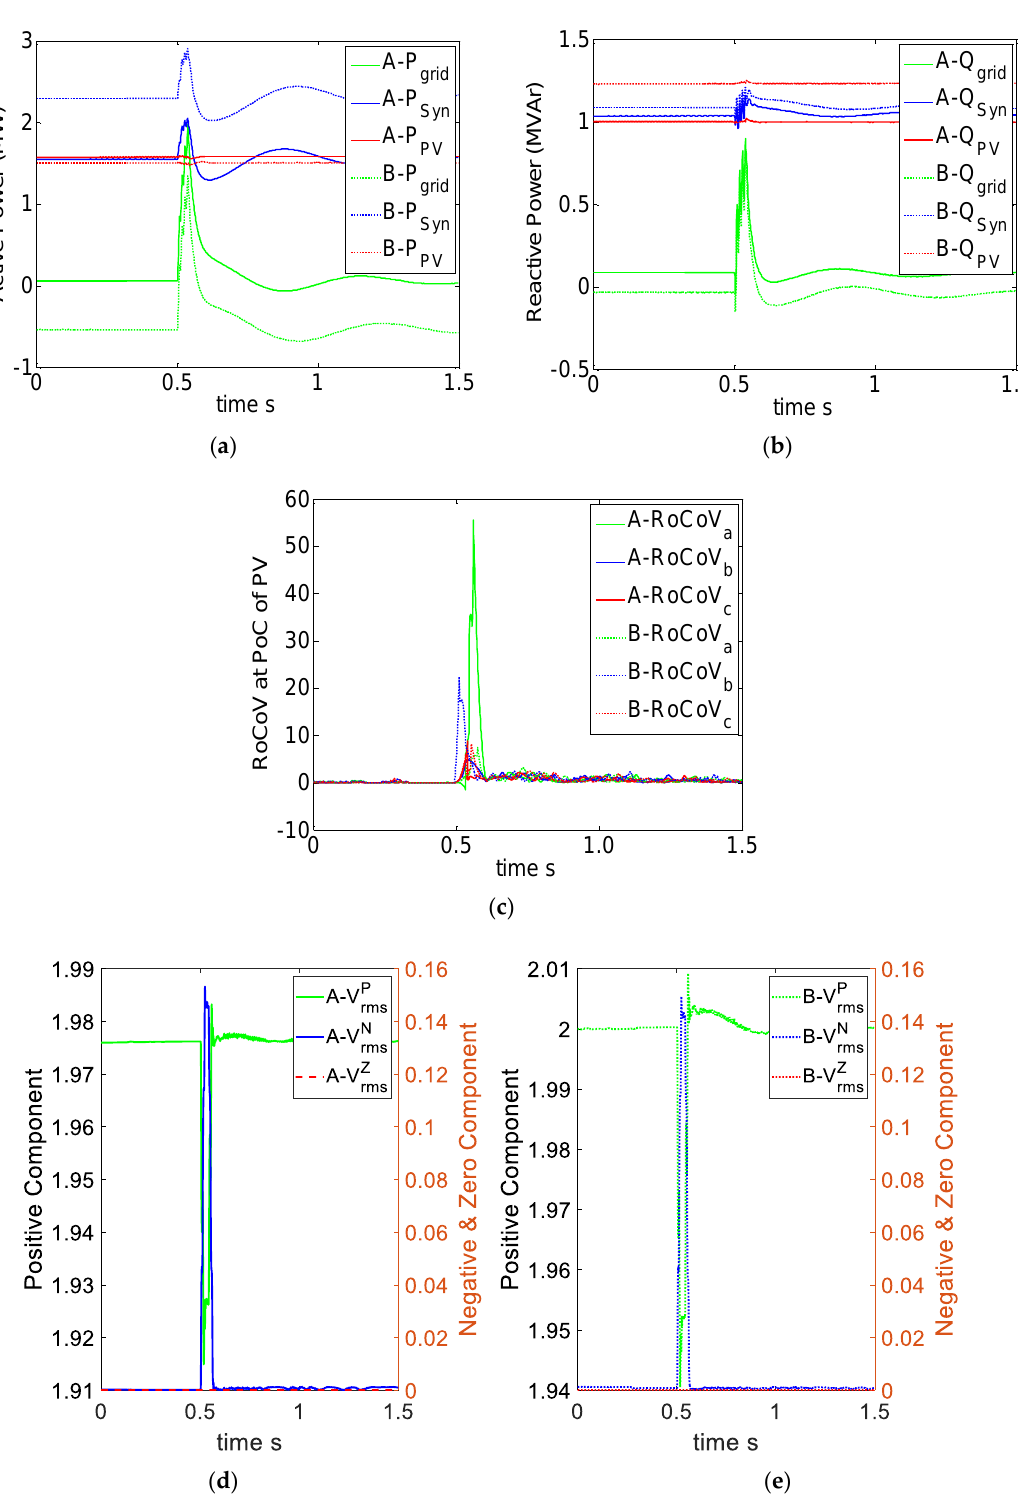
Figure 8. Single phase to ground fault case study ( a ) Active power generation of DGs and grid for case 2, scenario A and B; ( b ) Reactive power outputs of DGs and grid for case 2, scenario A and B; ( c ) Rate of change of voltages at the PoC, scenario A and B; ( d ) Symmetrical component of the voltage at the PoC, scenario A; ( e ) Symmetrical component of the voltage at the PoC, scenario B.